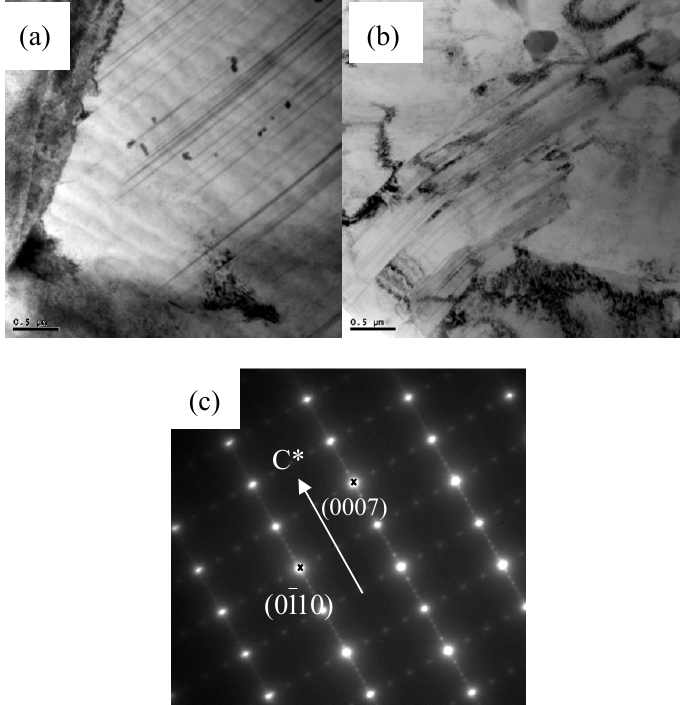
Figure 4. TEM image and corresponding SAED pattern of lamellar phase. ( a ) TEM image of lamellar phase in the forged alloy; ( b ) TEM image of lamellar phase in the extruded alloy; and ( c ) SAED pattern of lamellas in ( d ). Electron beam is parallel to [2110] a